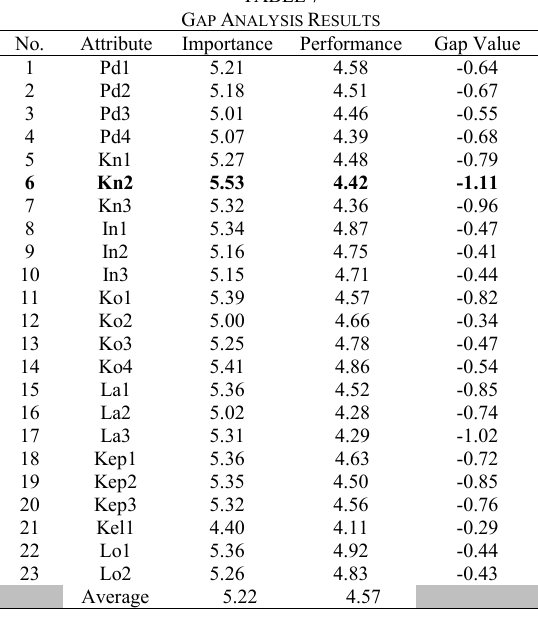
TABLE 7 G AP A NALYSIS R